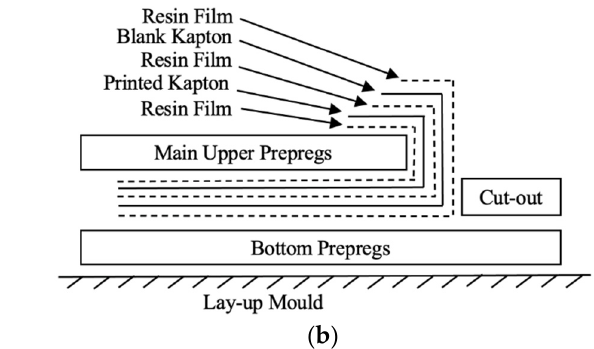
Figure 1. Schematics of ( a ) general drawing of repair patch and ( b ) embedding procedure during layup. 图 1 要更新